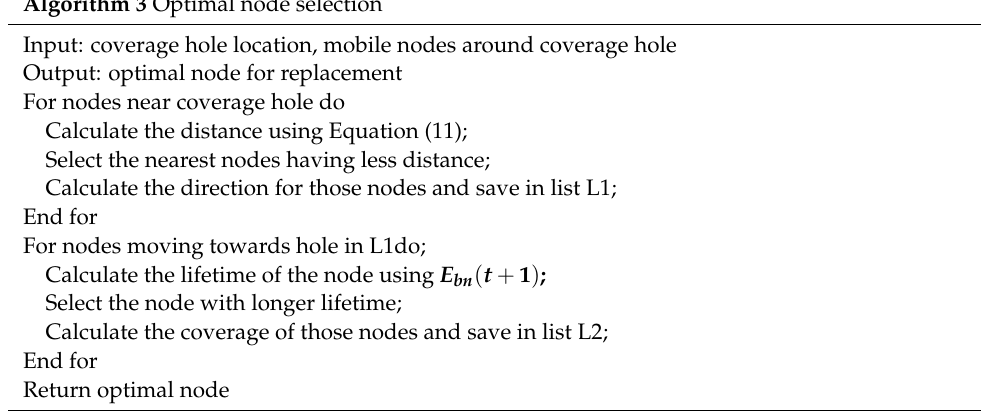
Algorithm 3 Optimal node